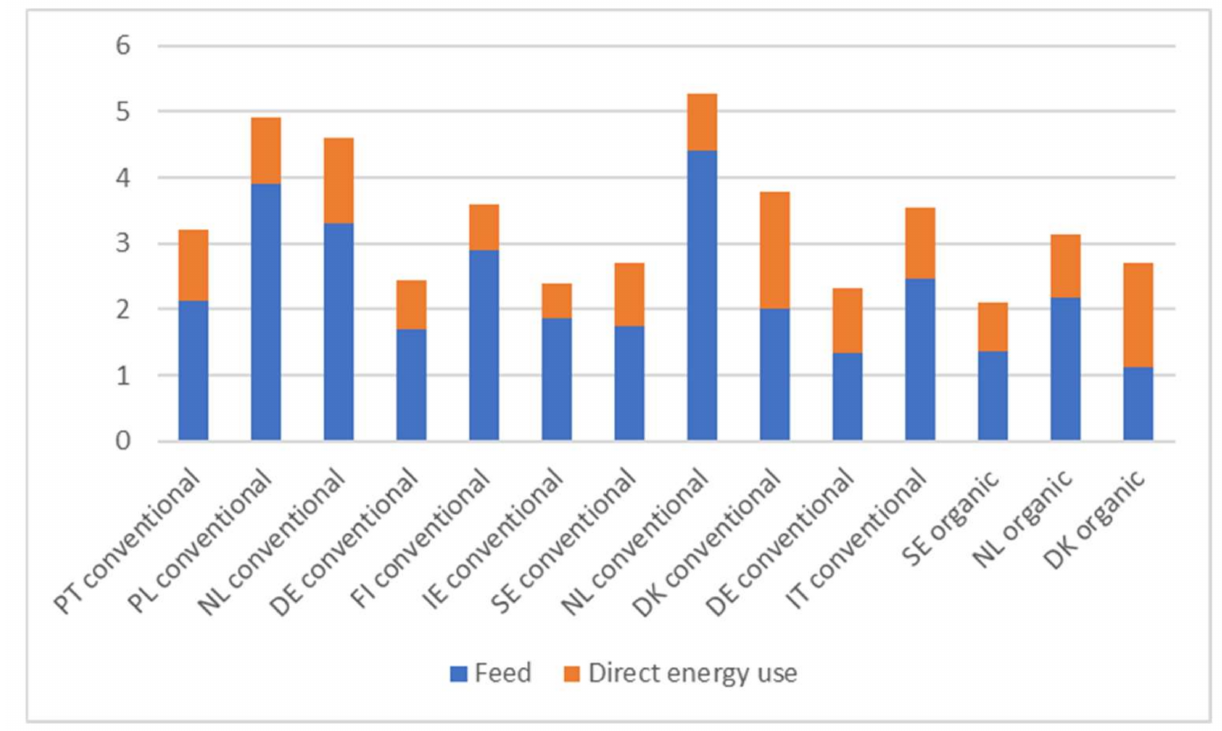
Figure 2. Energy inputs cow milk MJ/ECM (kg) (based on [21,23,25,45]).